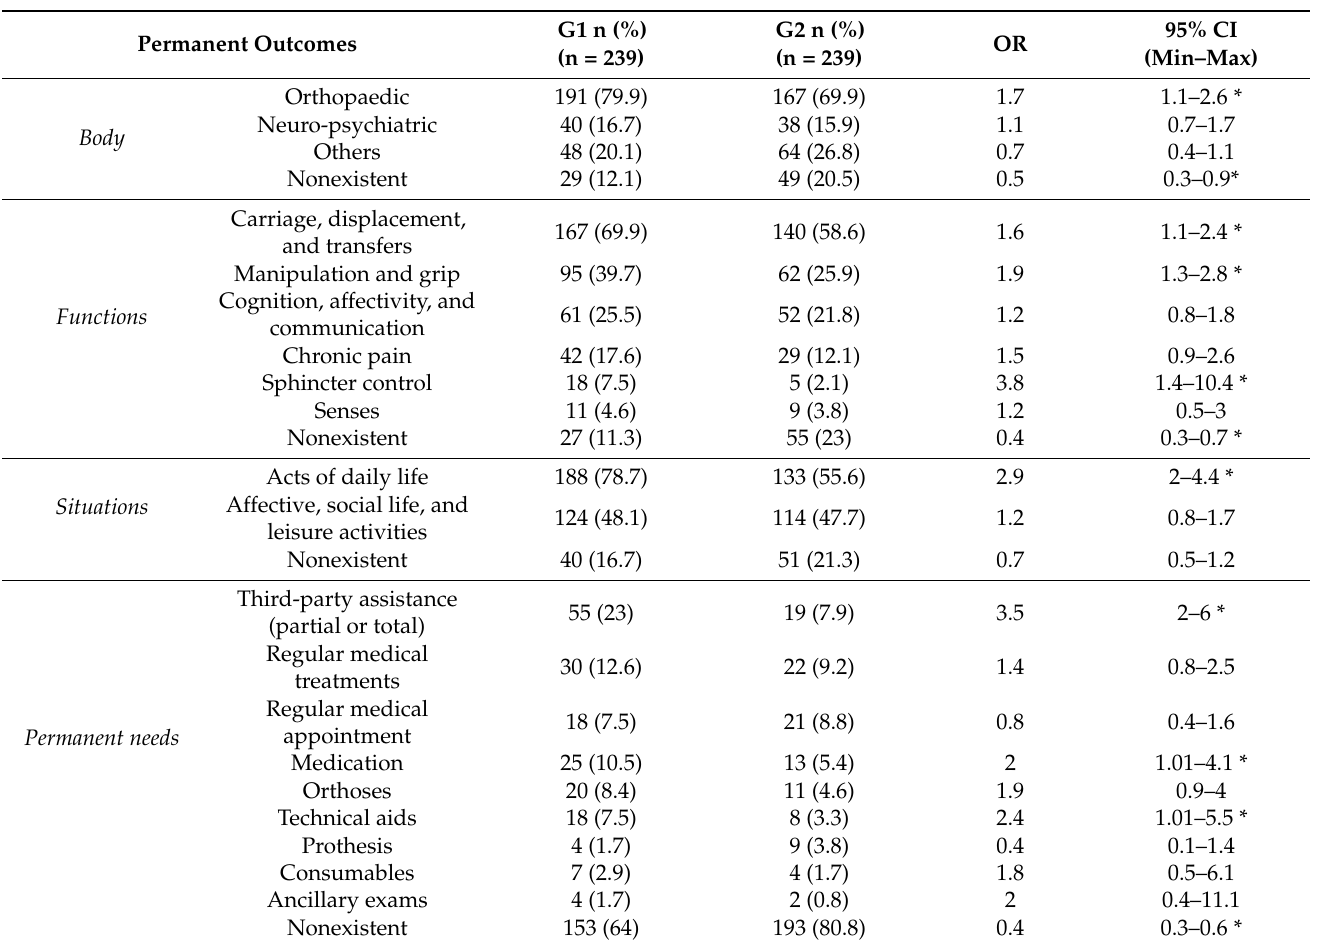
Table 3. Permanent outcomes ( three-dimensional methodology